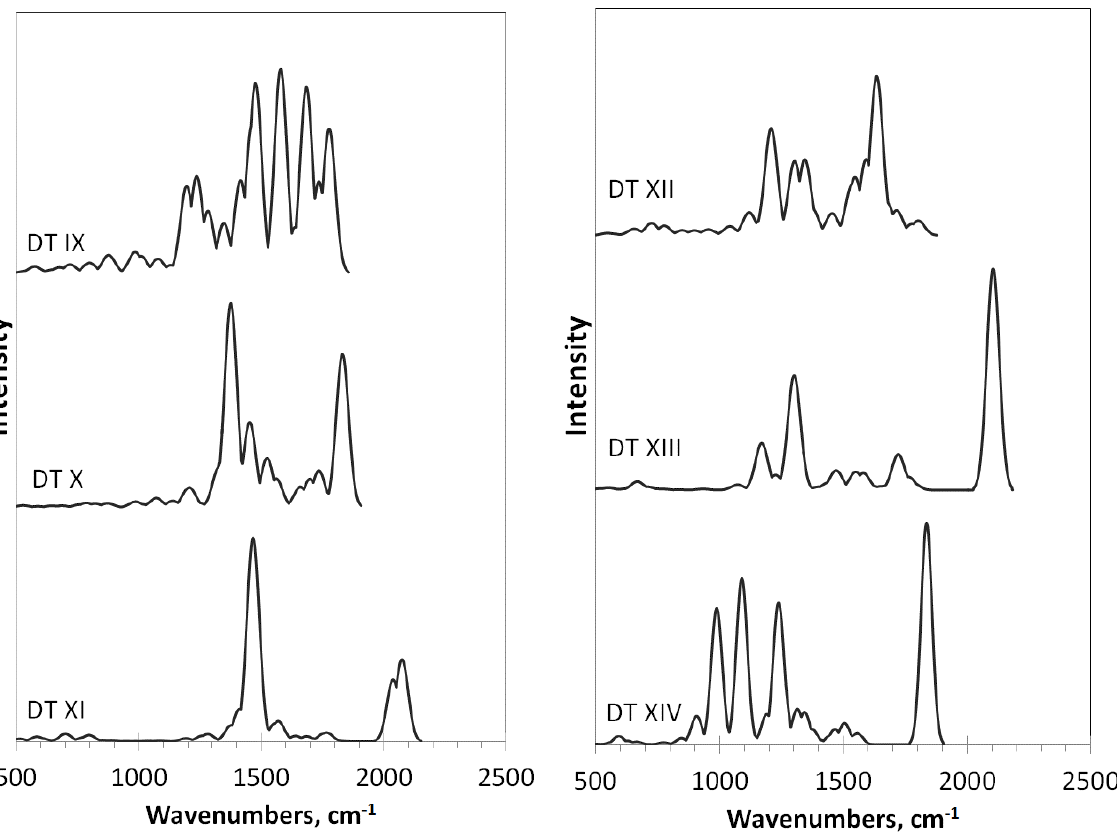
Figure 6. The virtual one-phonon IR absorption spectra of DTs IX – XIV. The Gaussian convolution of the original stick bars performed with a FWHM of 60 cm −1 . UHF AM1 calculations.